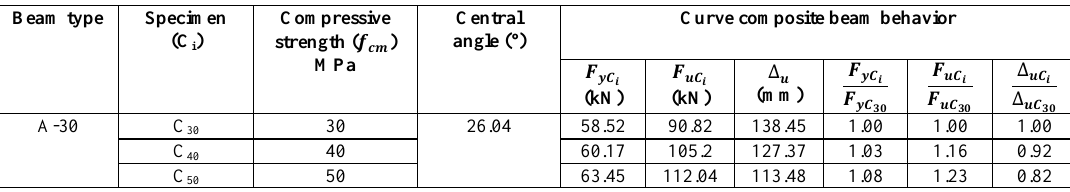
Table 8. Effect of compressive strength on curve composite